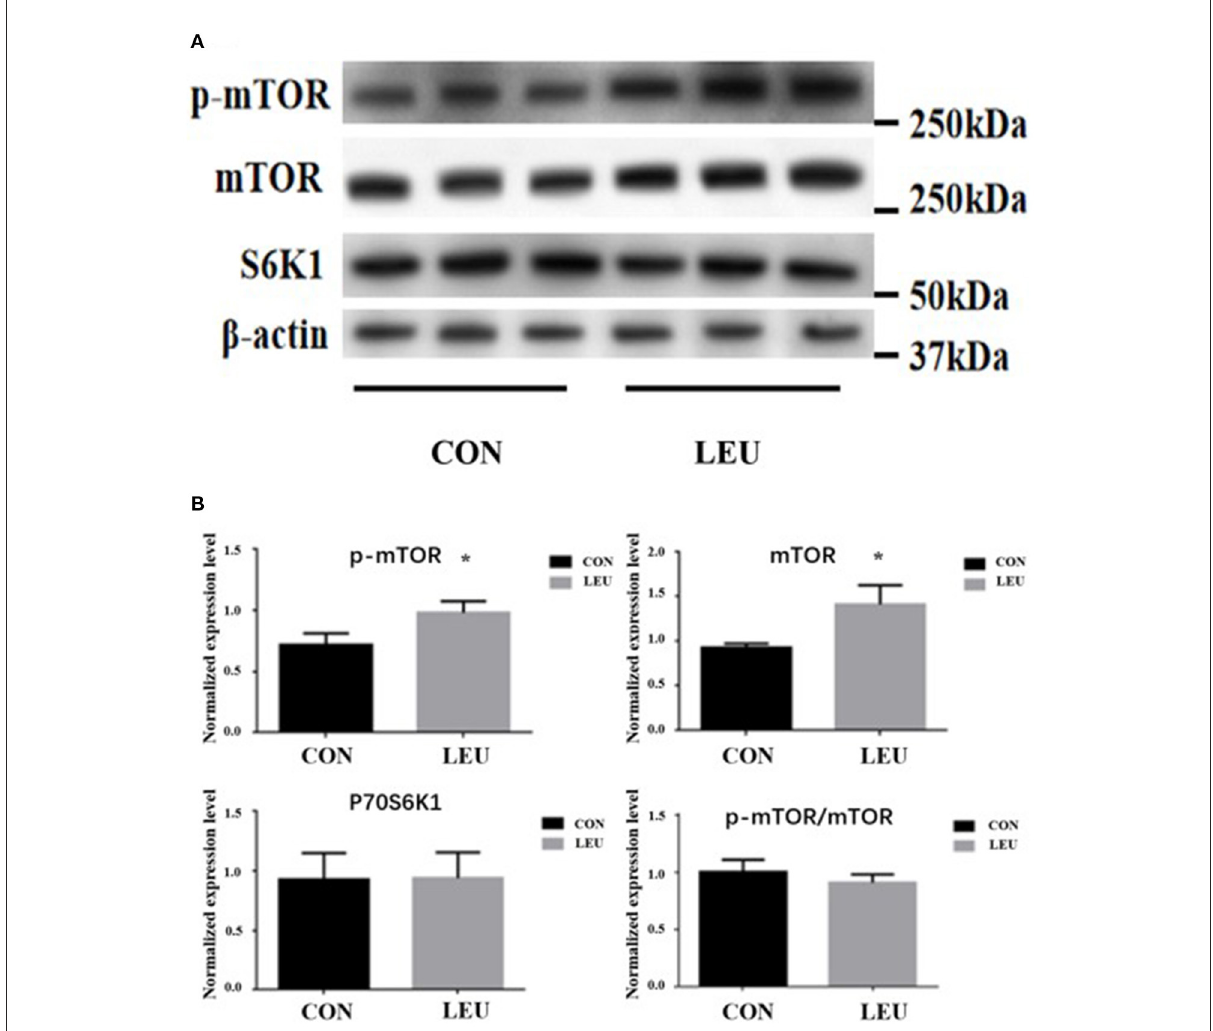
FIGURE6 (A,B) Effects of dietary leucine supplementation on protein expression of mTOR signaling pathway in the testis of boars. CON, control group; LEU, leucine group. Values are means with their standard errors represented by vertical bars ( n = 15 ). The * symbol indicates the values of P < 0.05